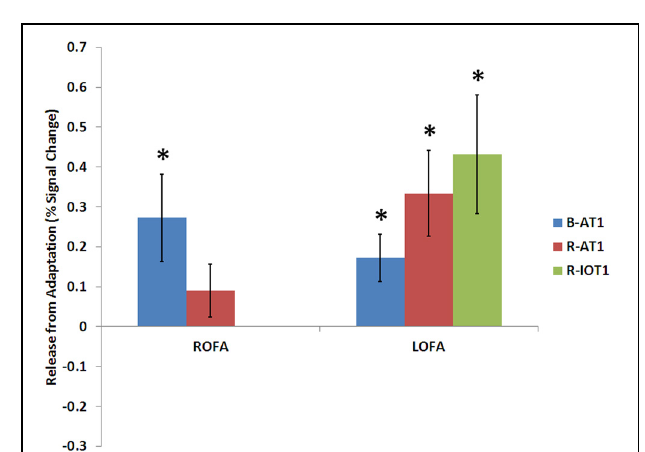
FIGURE 5 | Release from adaptation in response to identity changes as seen in the fusiform face areas of the three patients. Significant release from adaptation was observed in the right FFA of both B-AT1 and R-AT1. In contrast, R-IOT1 who did not have a right FFA due to damage, exhibited significant release from adaptation in the left FFA. ∗ p < 0 . 05.